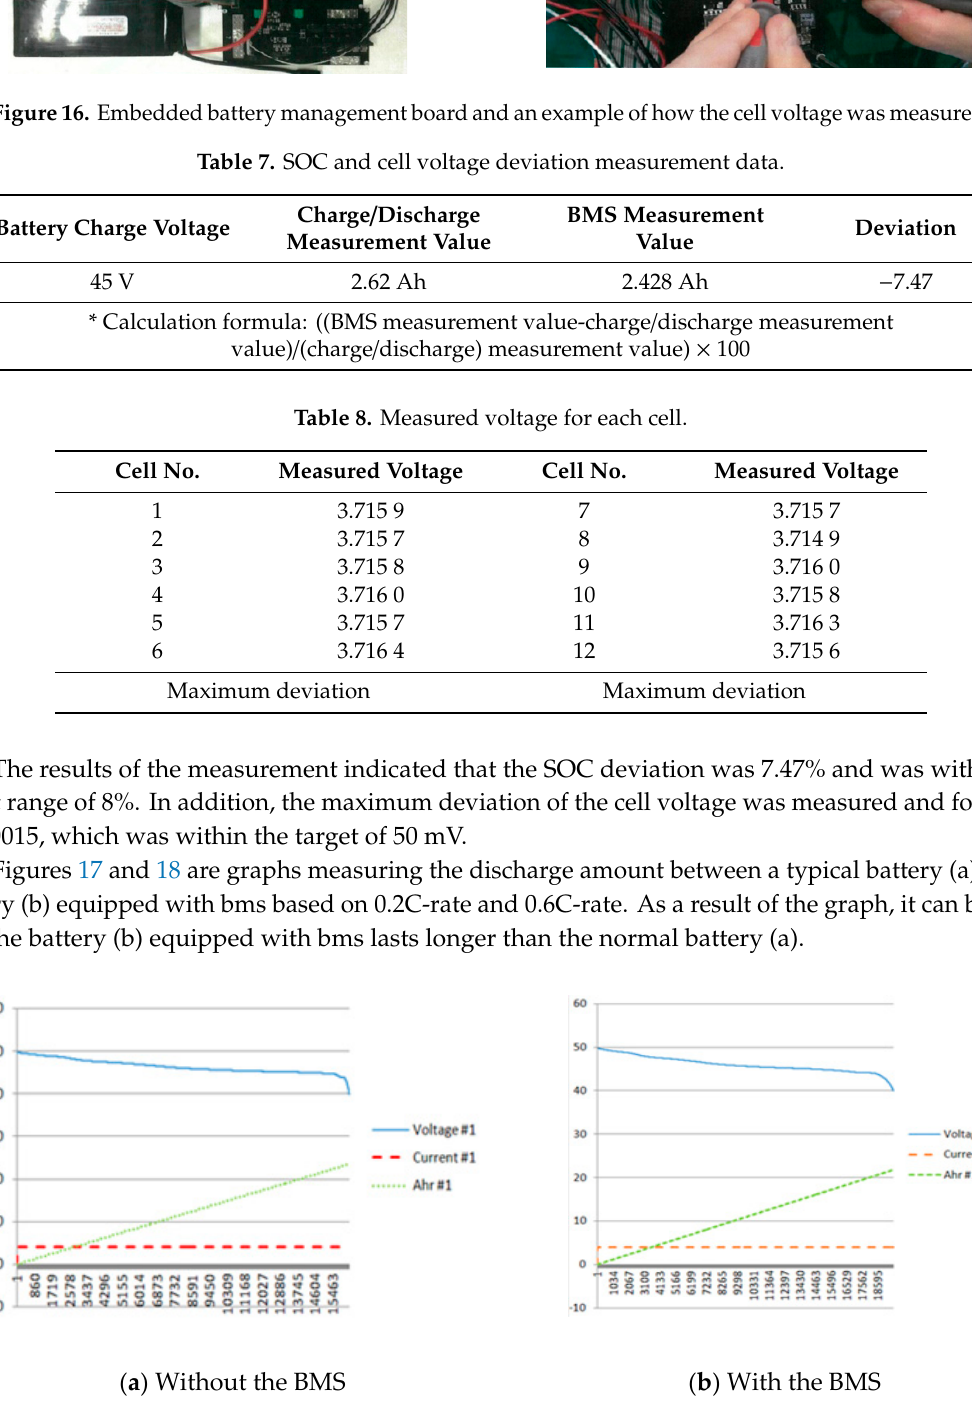
Figure 17. Comparison of the 0.2 C discharge outcomes: ( a ) Battery only, and ( b ) with the BMS.